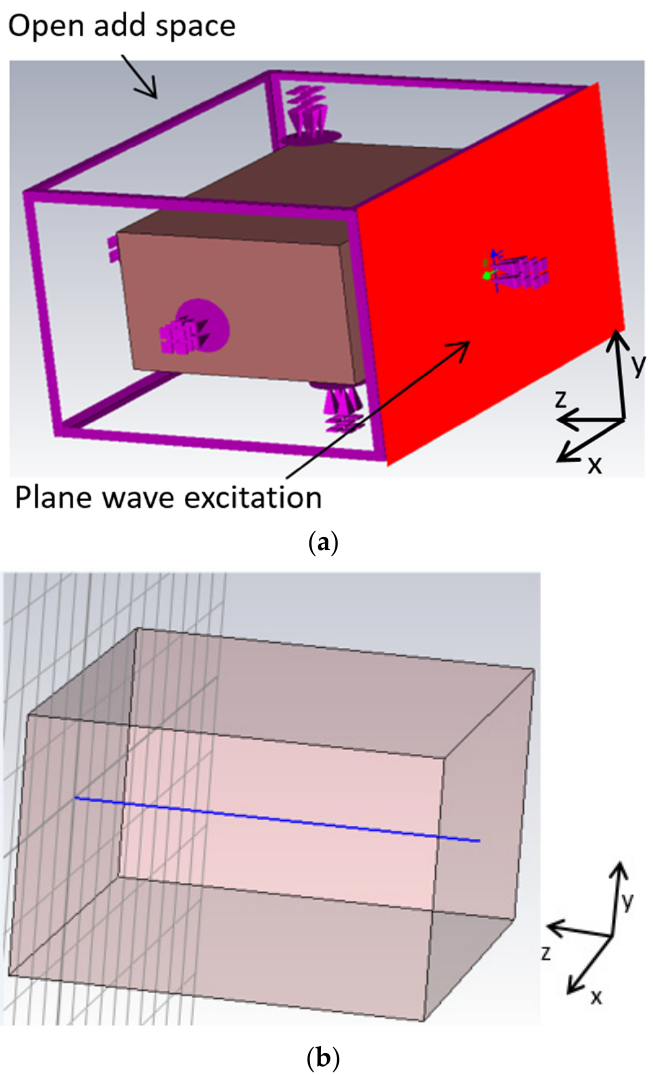
Figure 1. ( a ) Simulation setup showing the calculation domain (in the example with “open add space” boundary condition) and plane wave excitation. ( b ) Illustration of the direction along the z axis where the electric field is evaluated.